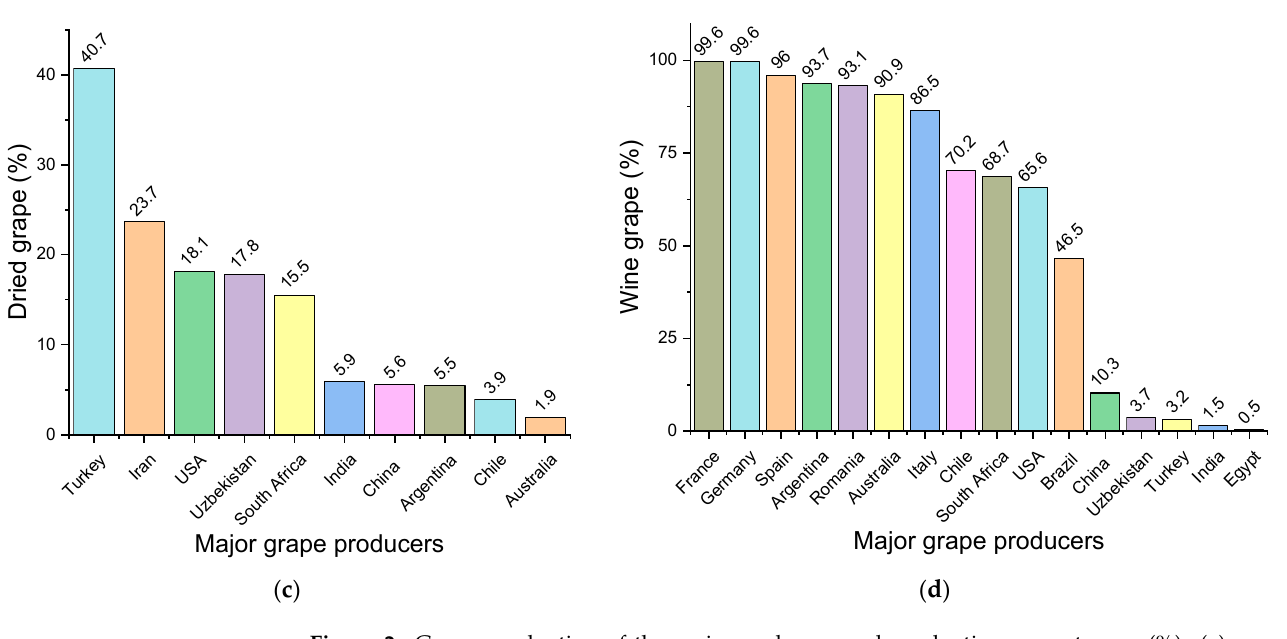
Figure 2. Grape production of the main producers and production per category (%): ( a ) grape production by country; ( b ) table grape production (%); ( c ) dried grape production (%); ( d ) wine grape production (%).